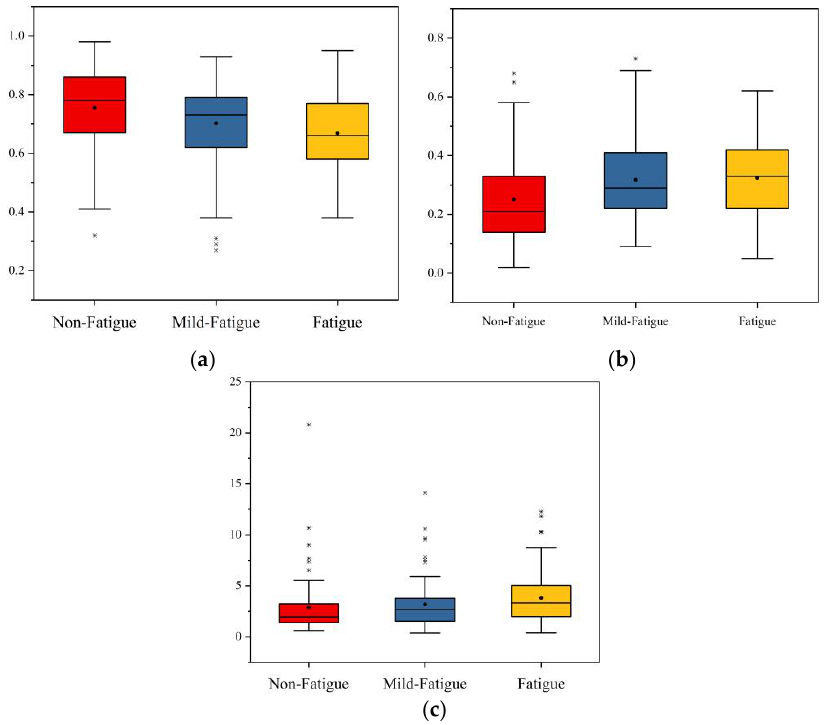
Figure 11. The boxplot of the frequency domain indicator after feature selection. ( a ) The boxplot of LFnorm. ( b ) The boxplot of HFnorm. ( c ) The boxplot of LF/HF.